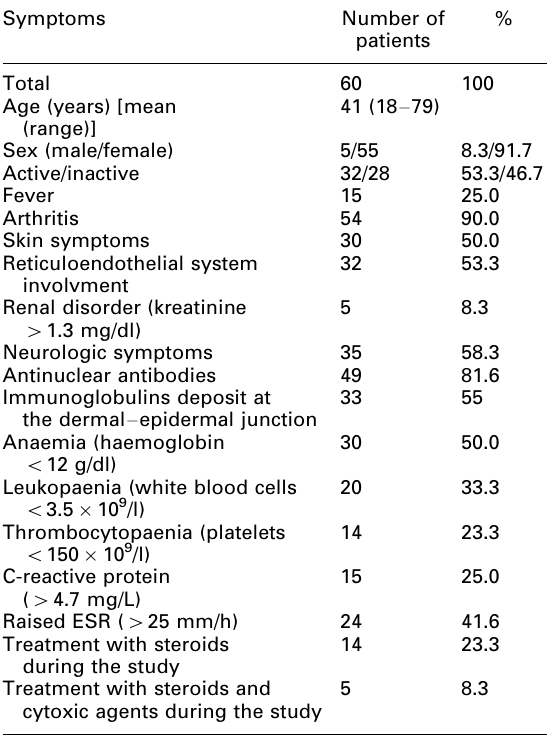
Table 1. Clinical and laboratory characteristics of SLE patients